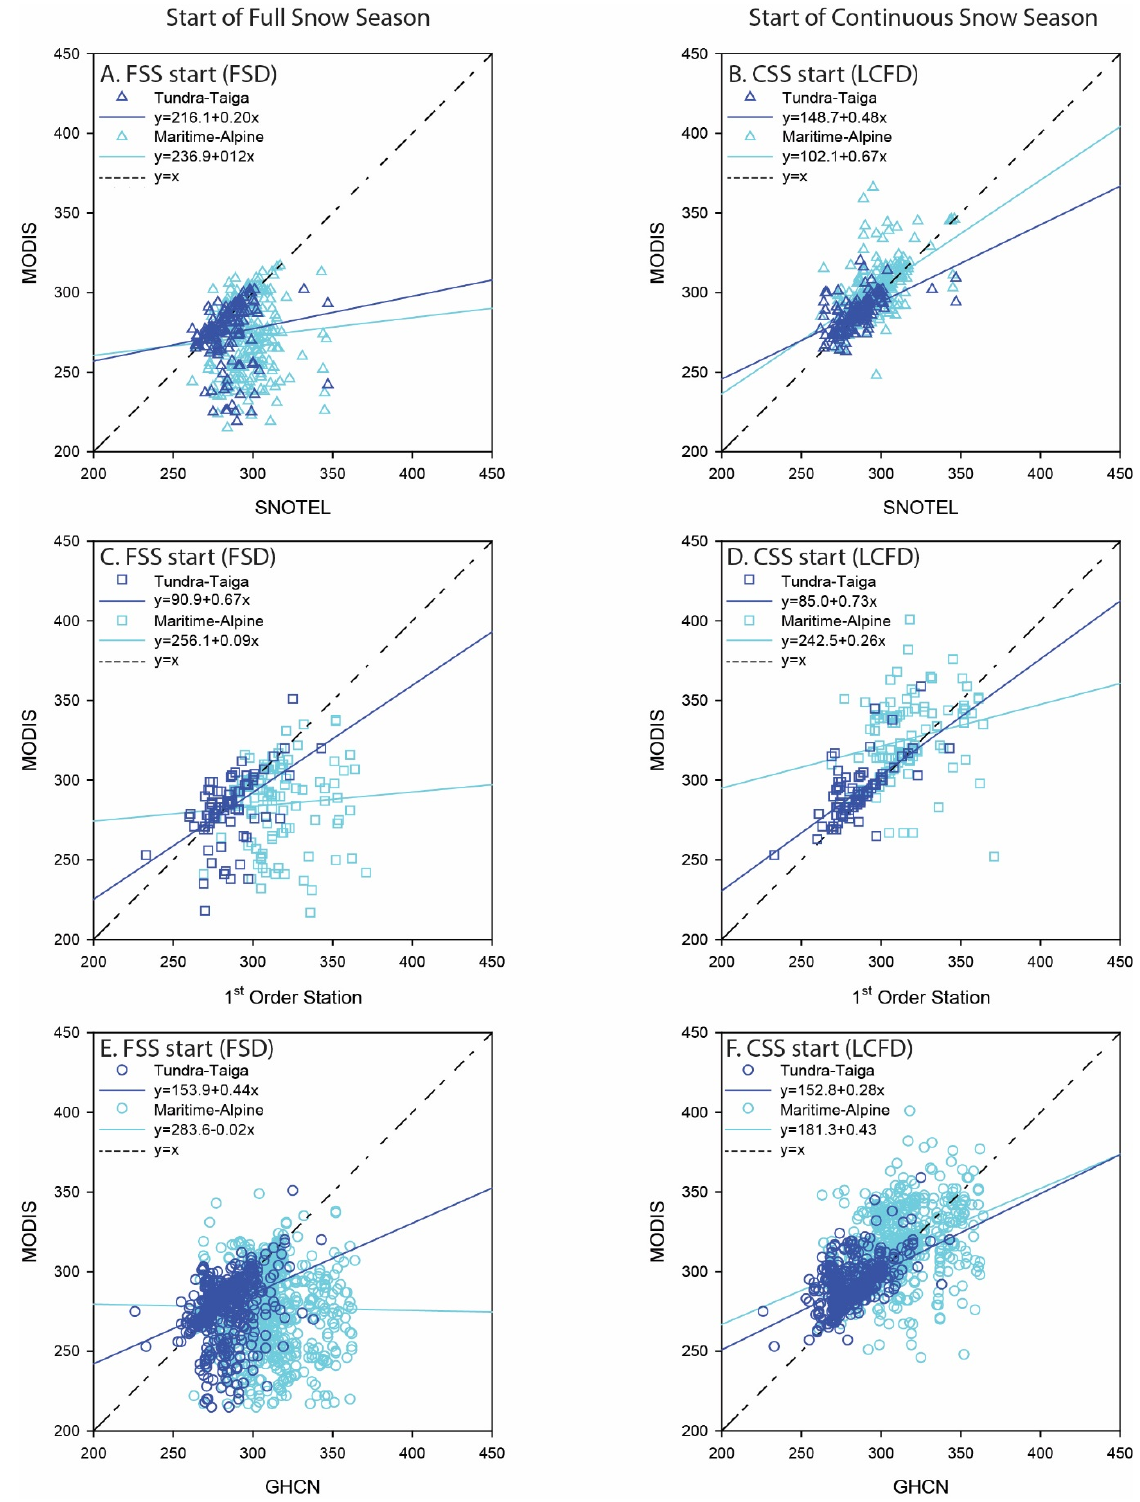
Figure 3. MODIS derived snow onset dates for first snow day (FSD) of the full snow season (FSS) and first day of the longest segment (LCFD) of the continuous snow season (CSS) versus in situ dates for 2001–2013. ( A ) FSD and SNOTEL stations; ( B ) LCFD and SNOTEL stations; ( C ) FSD at 1 st order stations; ( D ) LCFD and 1 st Order stations; ( E ) FSD and GHCN stations; and ( F ) LCFD and GHCN stations. Axes are day-of-snow-year, dashed line represents 1:1 agreement and solid lines show